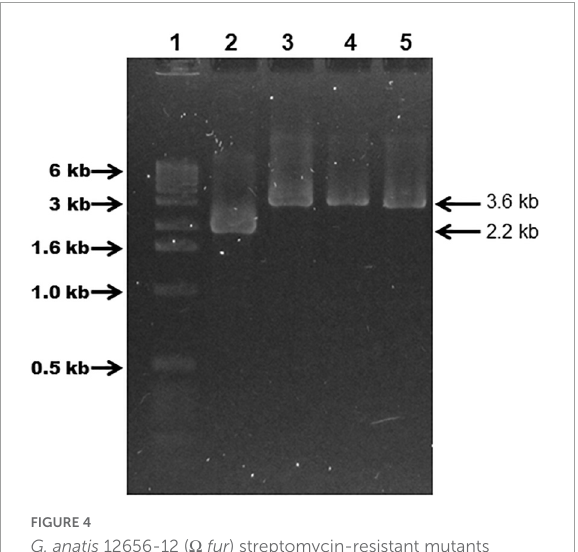
FIGURE4 G. anatis 12656-12 ( (cid:127) fur ) streptomycin-resistant mutants verified by PCR. Agarose gel (0.9%) showing 12656-12 fur WT (2.2 kbp band) and mutant fur::sm (3.6 kbp band) PCR amplification products obtained with G. anatis total DNA. (1) MWM, (2) G. anatis 12656-12, (3) construct pSAM (cid:127) fur in E. coli , (4) G. anatis (cid:127) fur 126.3, (5) G. anatis (cid:127) fur